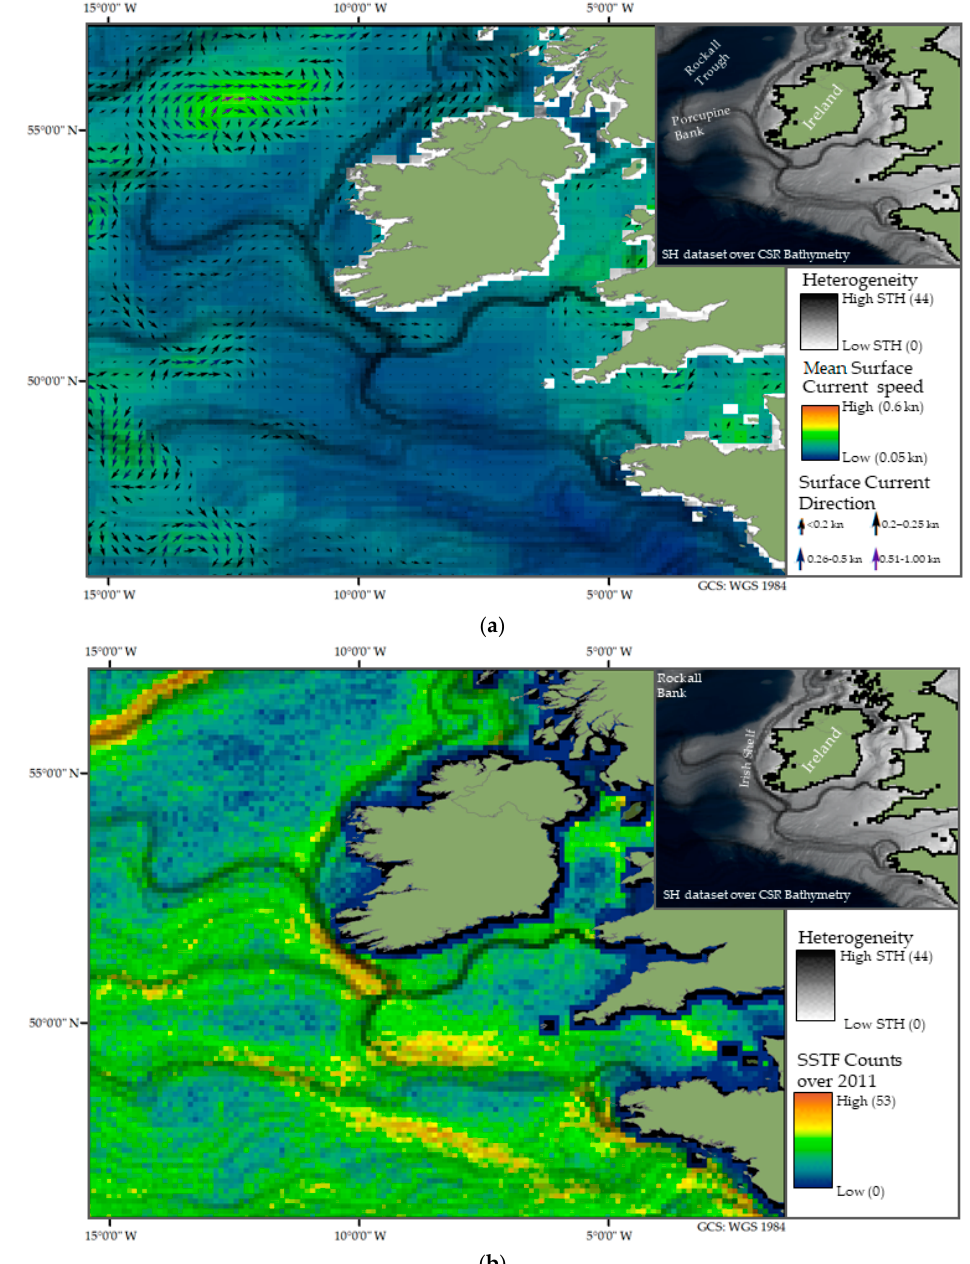
Figure 13. STH dataset alignment in the CSR with the parameters mean sea surface speed (µSSSp) and SST Fronts (SSTF), identified by GLM as significant. ( a ) STH overlaying the 2011 µSSSp. Note that STH values have an inverse relationship with µSSSp. The mean surface current vectors (arrows) are also included to aid interpretation; ( b ) STH overlaying the 2011 SST Front count. Note that STH values have a direct relationship with front counts in this sub-region. Both panels provide contextual location information in the upper right hand side inset with GEBCO bathymetry. Note that for the CSR case study, the GLM explained ~17% of the variability in the STH values.